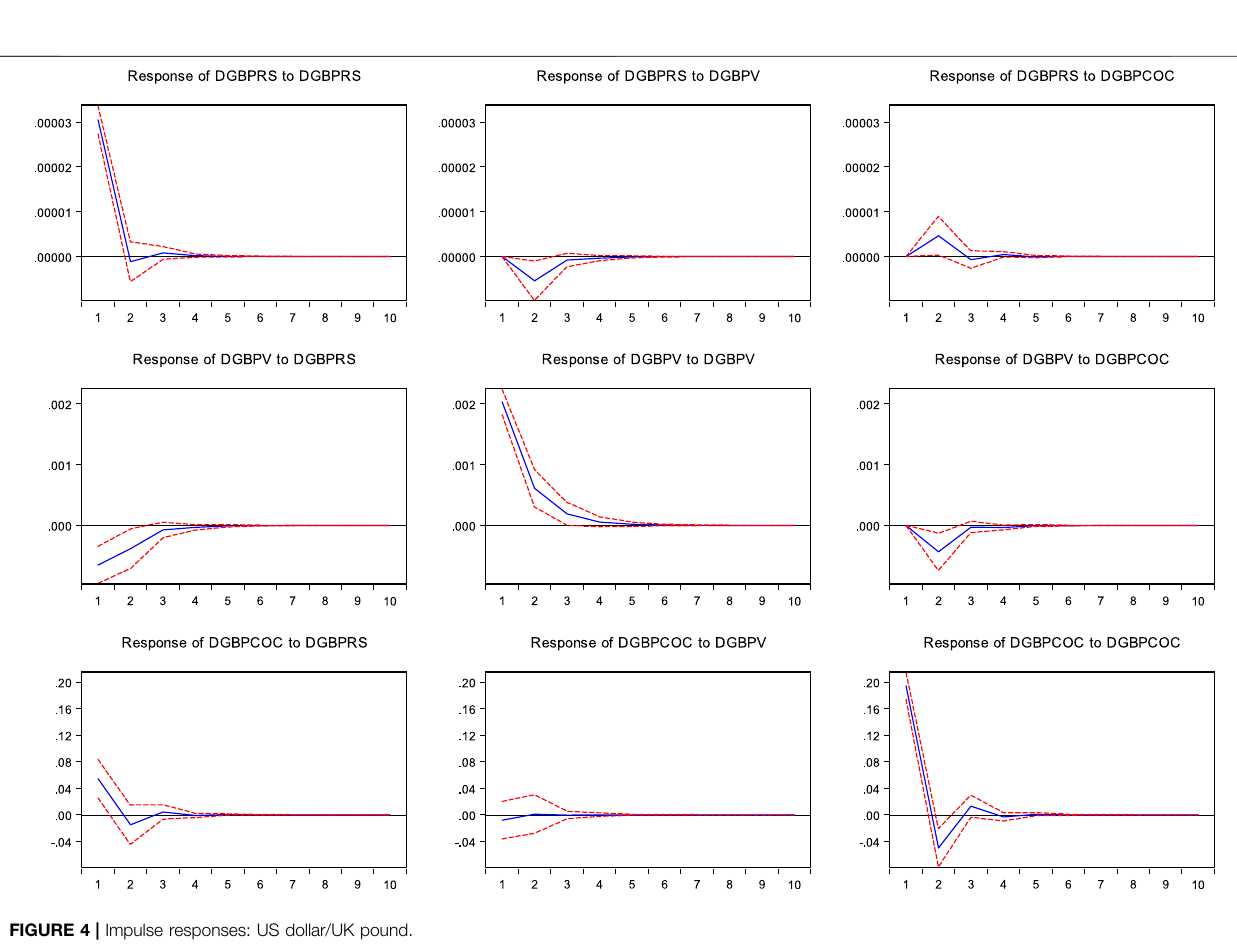
FIGURE 4 | Impulse responses: US dollar/UK